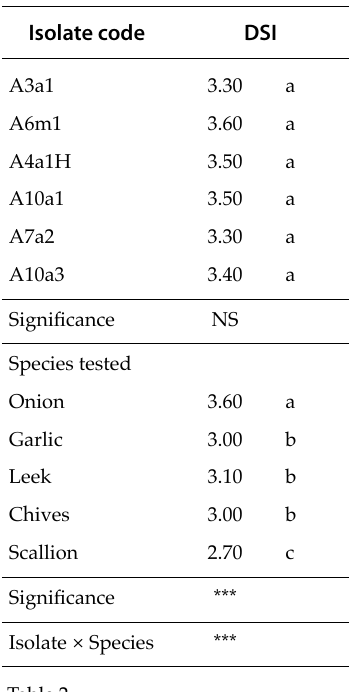
Table 4. multiway aNova for the evaluation of Allium species susceptibility (Disease Severity Index ‒ DSI) fol - lowing artificial inoculation with isolates of F. proliferatum originating from garlic.